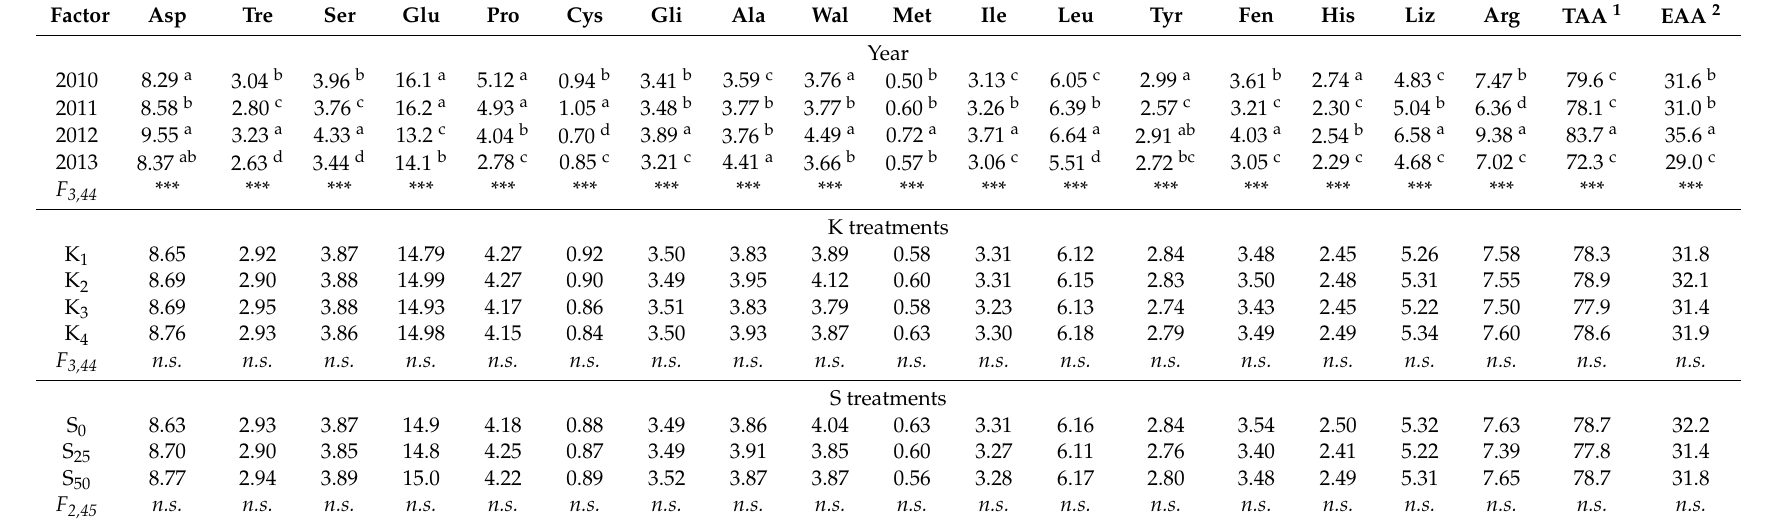
Table 5. E ff ect of growing season, K treatment, and S application on amino acid composition of immature seeds (GS) of faba bean (g 100g − 1 of CP). Factor